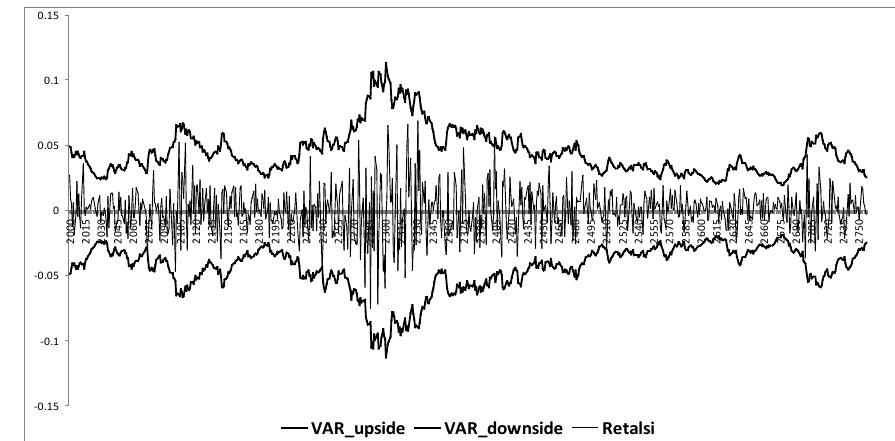
FIGURE 4: Egarch-T Source: Authors’ calculations, based on JSE ALSI return